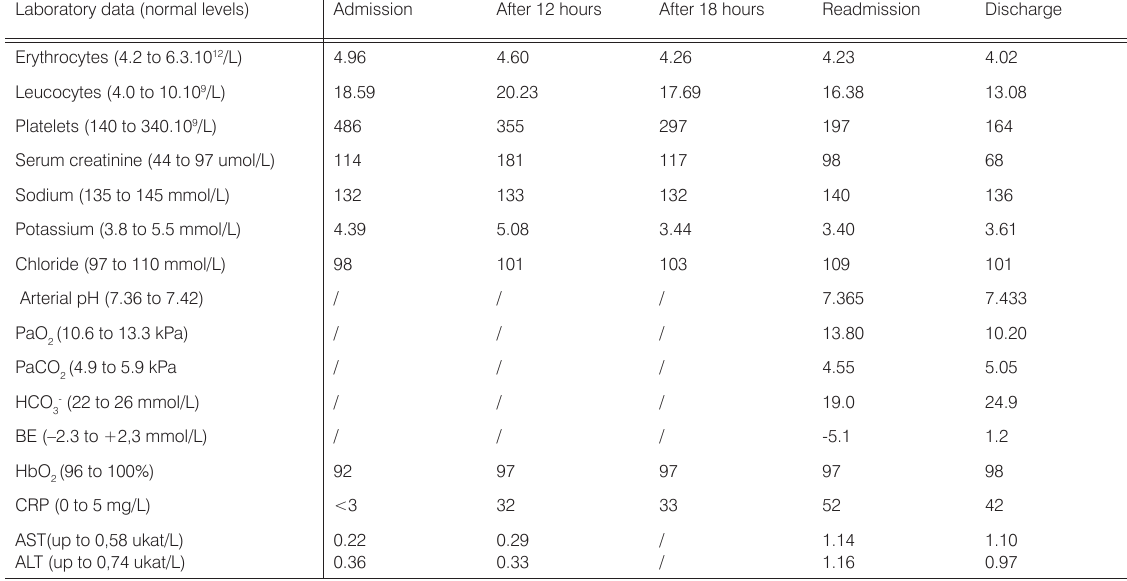
Table 1. Laboratory